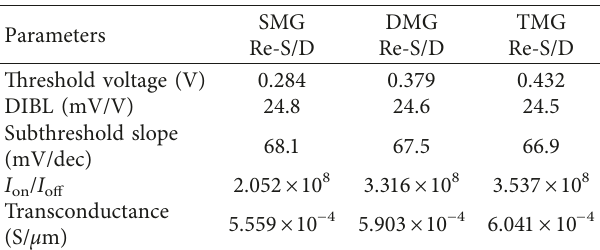
Table 2: Performance comparison of SMG, DMG, and TMG Re-S/ D SOI MOSFET.